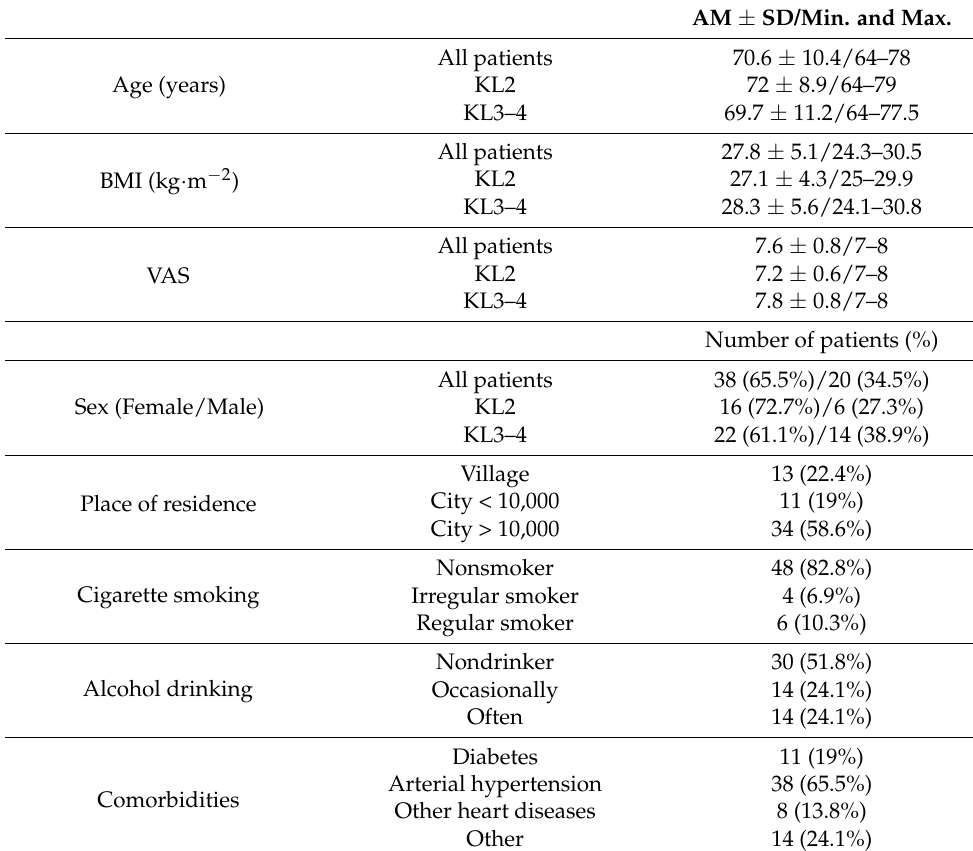
Table 1. Information on patients included in the study ( N =